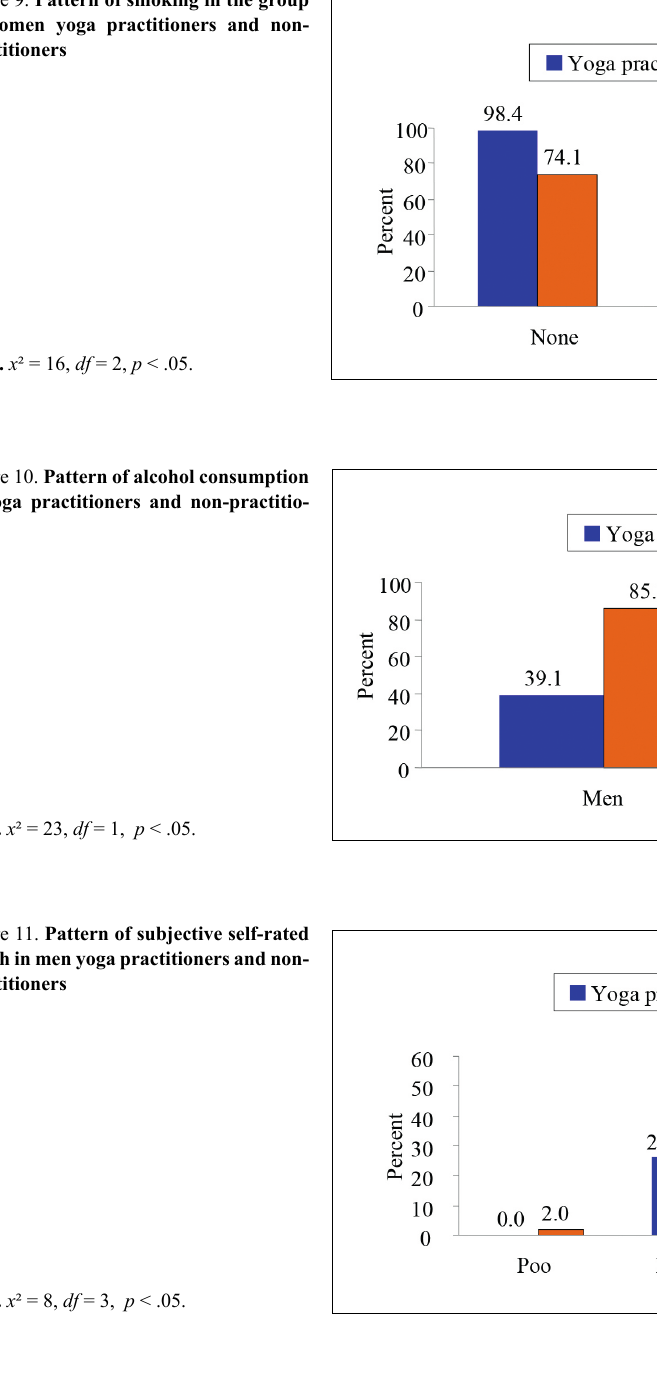
Figure 9. Pattern of smoking in the group of women yoga practitioners and non- practitioners